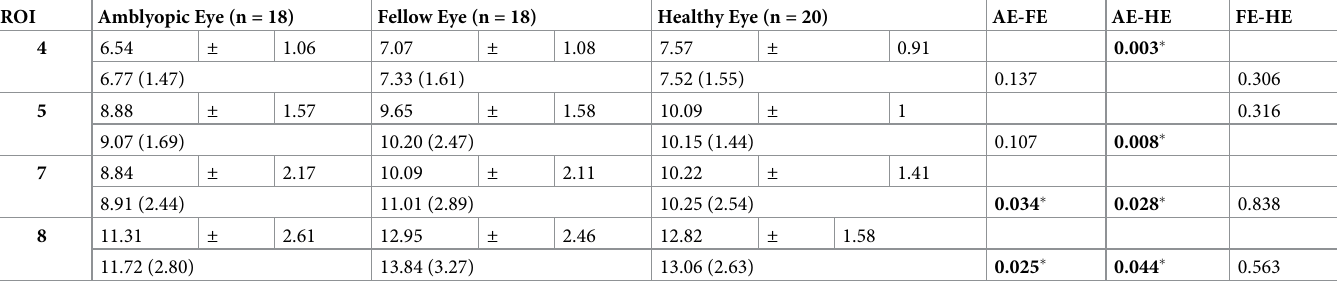
Table 3. Comparison of the reflectivity of ROIs 4,5,7 and 8 among AE, FE, and HE.